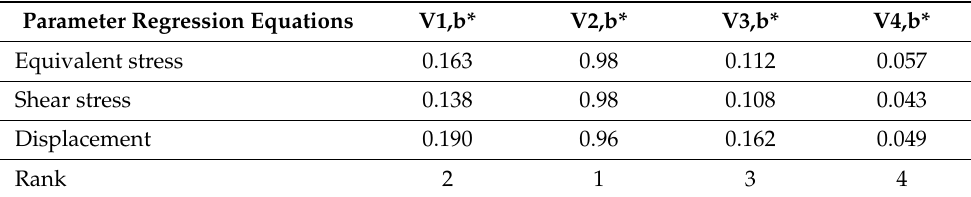
Table 8. The values of V1,b*,V2,b*,V3,b*,V4,b* for regression equations. Parameter Regression